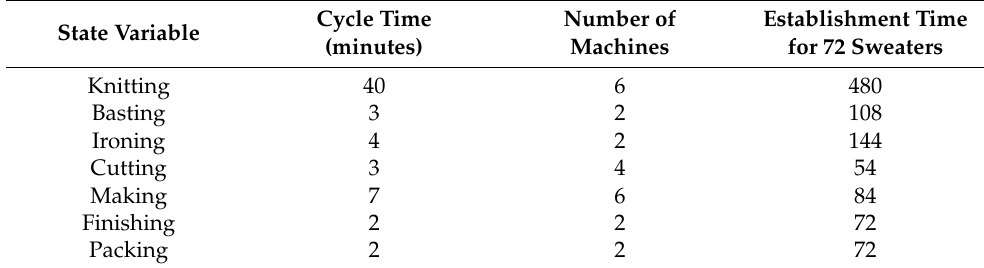
Table 1. Cycle times of the textile manufacturing